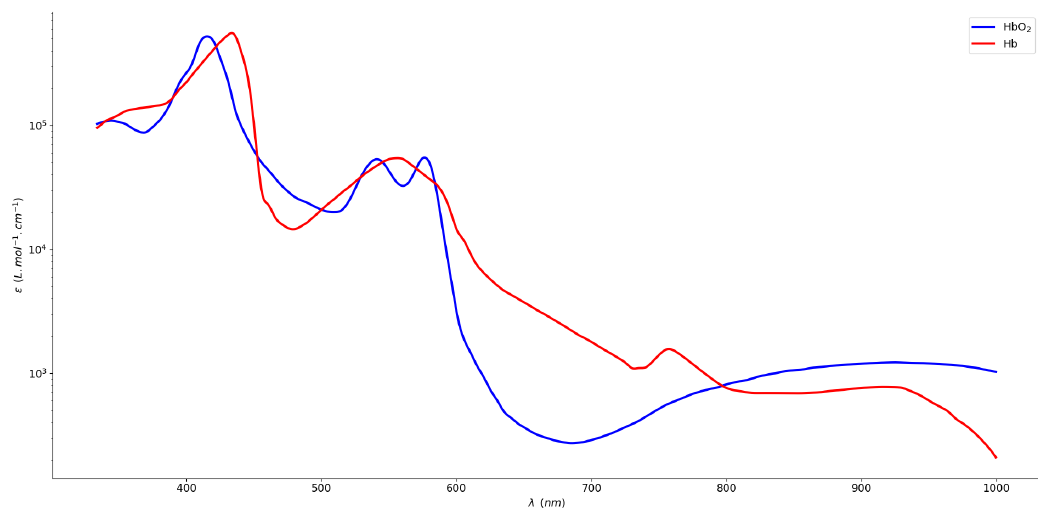
Figure 2. Extinction coefficients spectra of oxyhemoglobin and deoxyhemoglobin in the visible and NIR range, adapted from